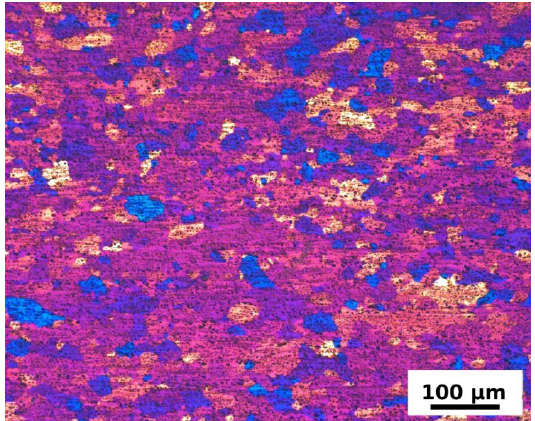
Figure 4. Light optical microscope (LOM) micrograph of the coarse grained structure in the F0 specimen in the initial state.